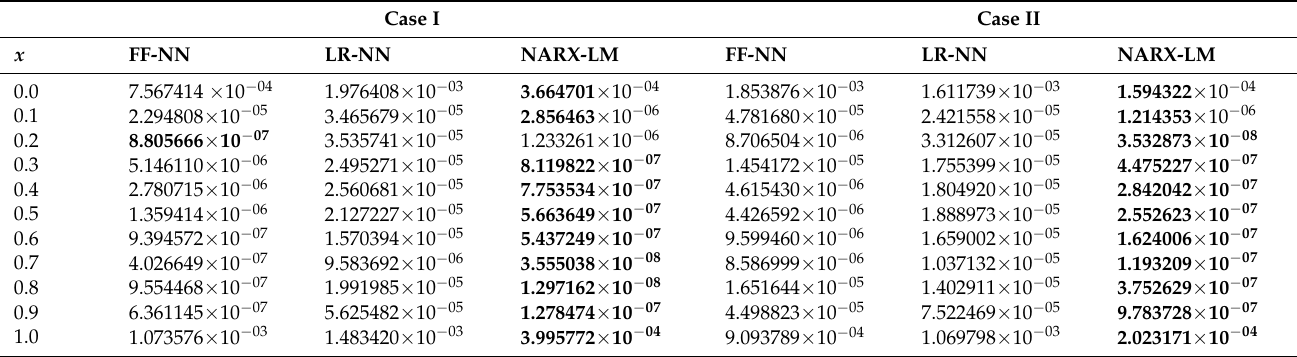
Table 3. Comparison of the absolute errors in solutions for the concentration of CO 2 obtained by the NARX-LM algorithm with different machine learning techniques for Case I and II.